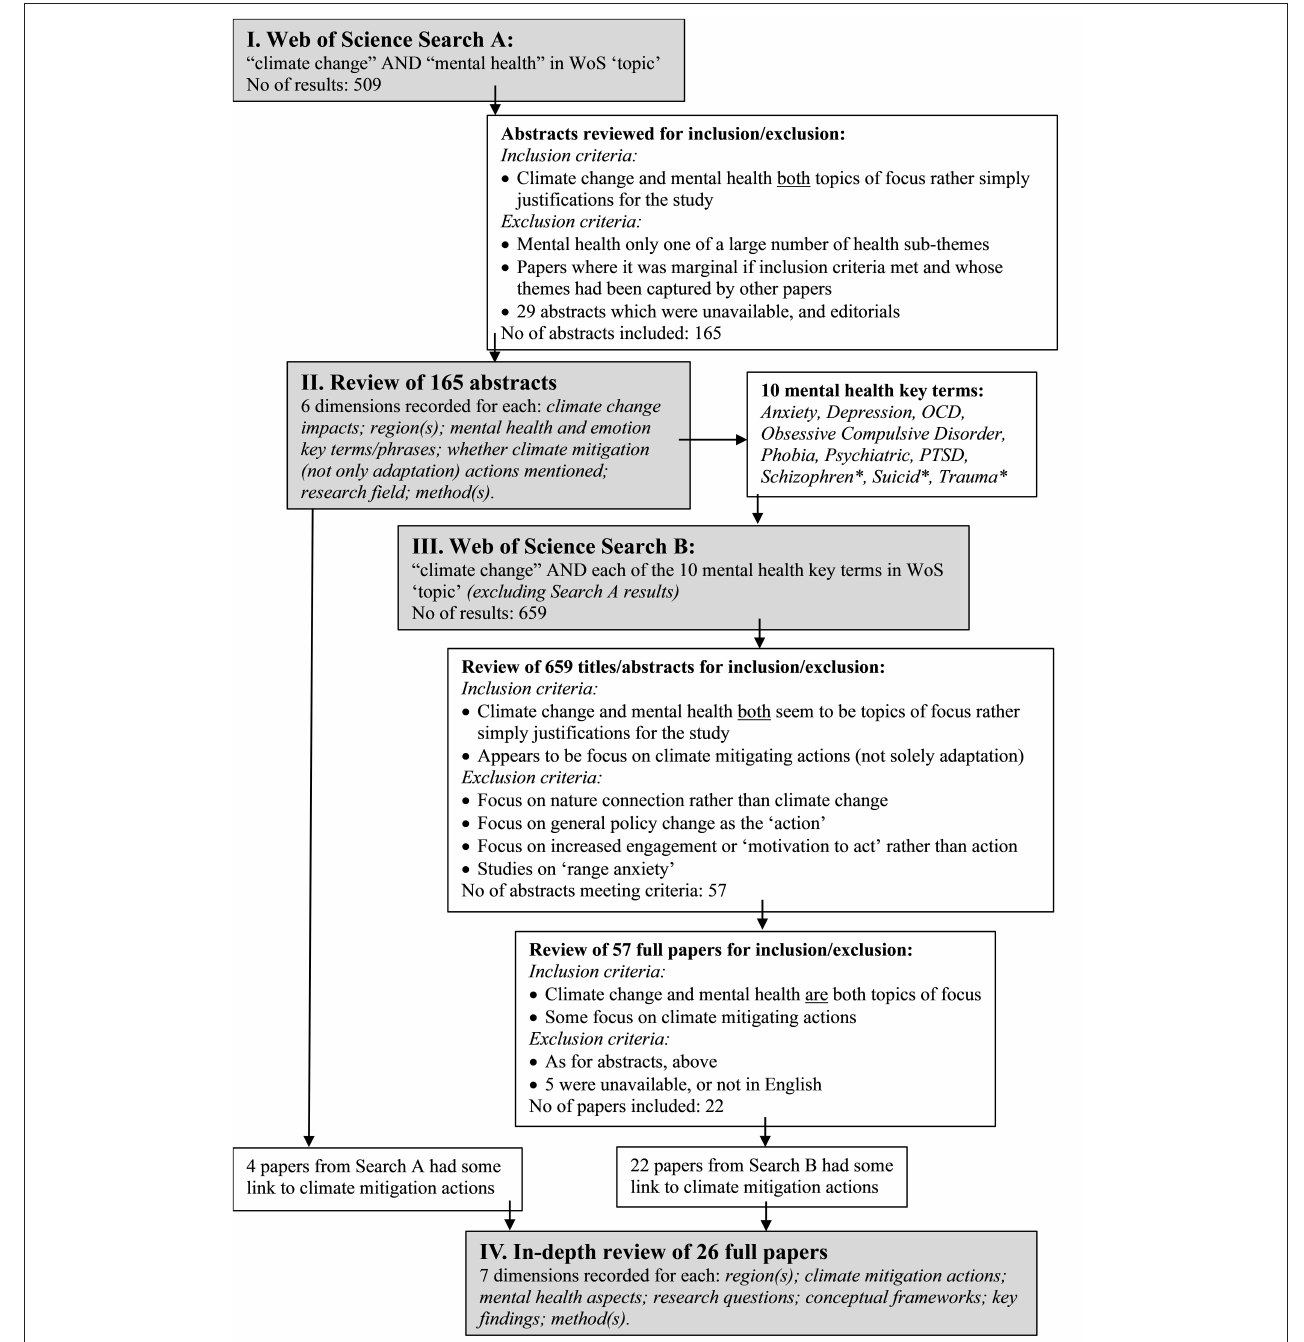
FIGURE 1 | Systematic review method, with inclusion/exclusion